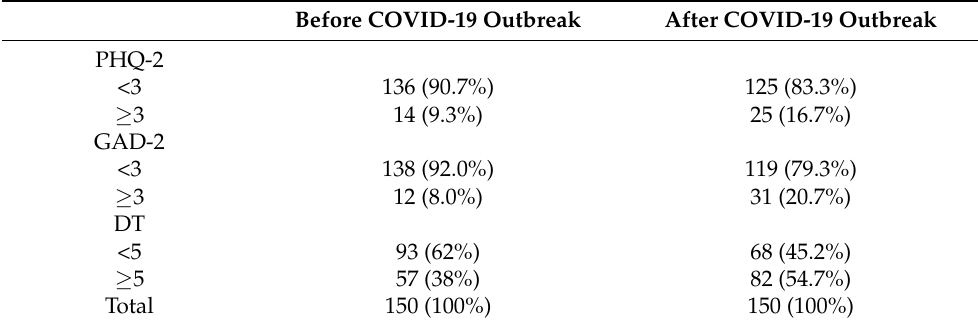
Table 2. Prevalence of depression symptoms, generalized anxiety symptoms, and distress before and after the outbreak of COVID-19 in cancer patients.